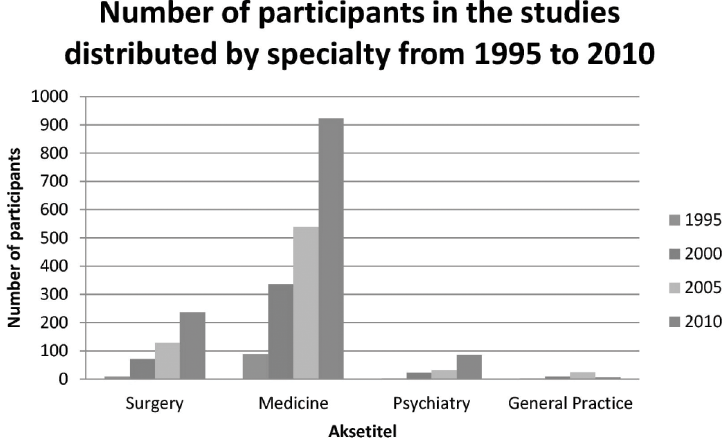
Figure 5. Number of participants in the studies distributed by specialty from 1995 to 2010.